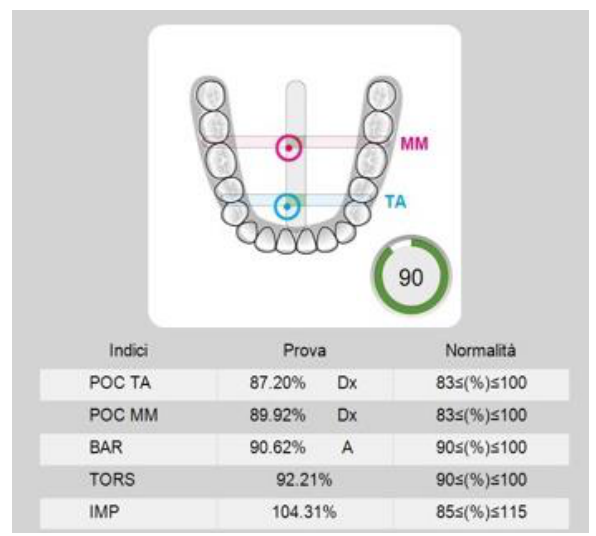
Figure 1. Electromyographic indexes and range of reference. POC TA: percentage overlapping coefficient of right and left Temporalis; POC MM: percentage overlapping coefficient of right and left Masseter muscles; BAR: occlusal barycenter; TORS: Torsion index; IMP: impact index. To assess the muscle symmetry, the EMG waves of paired muscles (right and left masseter and temporalis) were compared by computing the percentage overlapping coefficient (POC). When the muscles contract with perfect symmetry, a POC of 83% – 100% is obtained. The balance of the contractile activity of contralateral temporalis and masseter muscles (for example, left masseter and right temporalis), expressed by the Torsion index (TORS), ranges between 0% (complete lateral displacing force) and 100% (no lateral displacing force). The Barycenter index (BAR) was considered to investigate if the occlusal barycenter was in an anterior or posterior position. It identifies the most prevalent pair of masticatory muscles as the percentage ratio of the difference between temporalis and masseter standardized potentials (normal range 90% – 100%). The intensity of muscle work, expressed by the impact index (IMPACT), normally ranges from 100% – 115%. High values are typical in bruxist patients. Finally, the asymmetry index (ASIM) assessed the symmetry between right and left muscular activity ( − 10 < (%) > 10) (see Figure 2). The advantage of using these indexes lies in the possibility of evaluating the symmetry, or asymmetry, conditions of muscular activity [22].